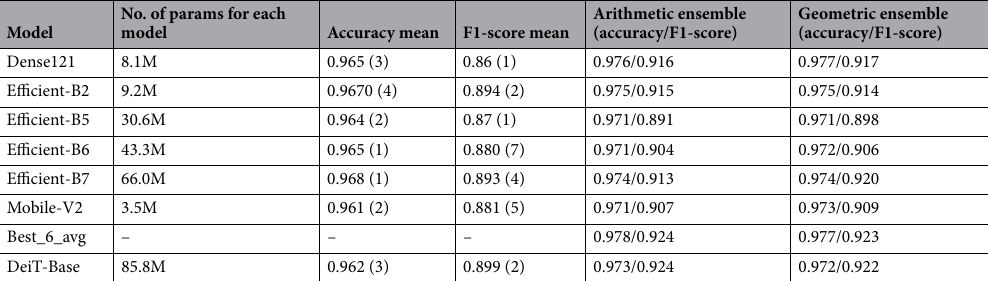
Table 1. Summary of the performance of the individual models on the ZooLake dataset. The ensemble score on the rightmost column is obtained by averaging across either 3 or 4 different initial conditions. The Best_6_ avg model is an ensemble of DenseNet121, EfficientNet-B2, EfficientNet-B5, EfficientNet-B6, EfficientNet-B7 and MobileNet (combining learners through an arithmetic mean) models 22 . The numbers in parentheses are the standard errors, referred to the last significant